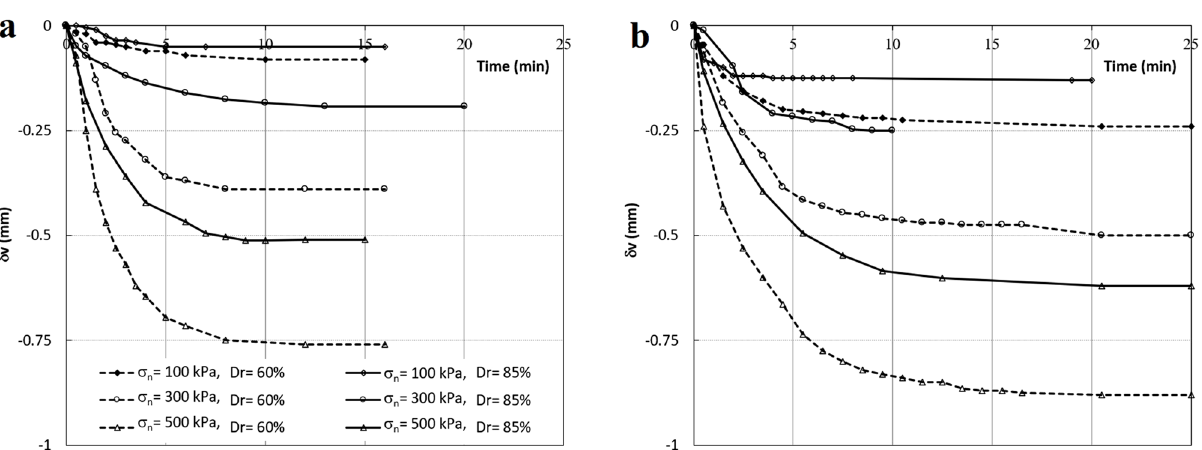
Figure 5. Effect of relative density and normal stress on the collapse settlement. ( a ) SL = 0. ( b ) SL = 50%.